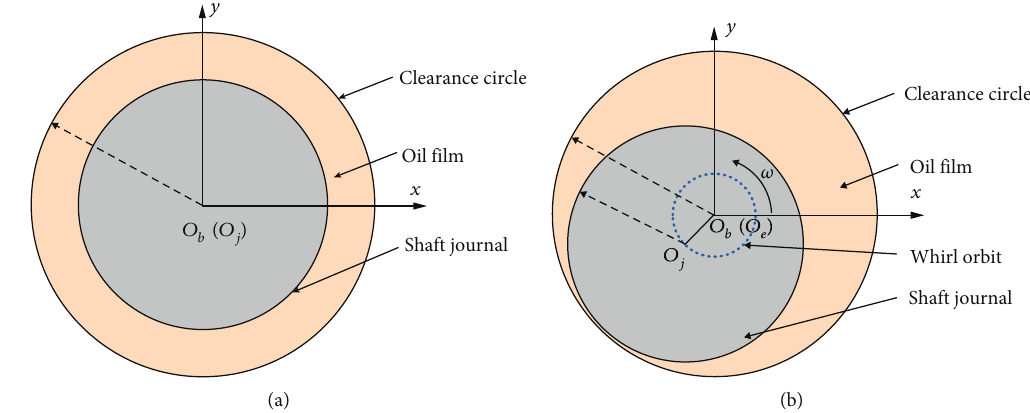
Figure 2: The SFD of the rotor system without static eccentricity. (a) In the static state. (b) In the working